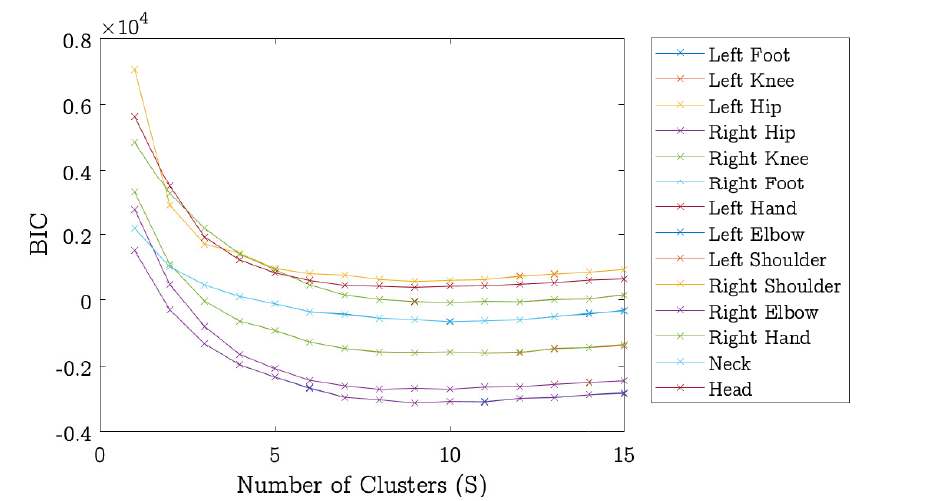
Figure 8. The number of clusters predicted by the Bayesian information criterion (BIC) for each body-part. A few plots are very close to each other and therefore they largely overlap and are not visible at this scale. Table 1. The predicted number of clusters by the Bayesian information criterion (BIC) and BIC value for each body-part. ’Emp.’ represents the number of clusters obtained empirically for each